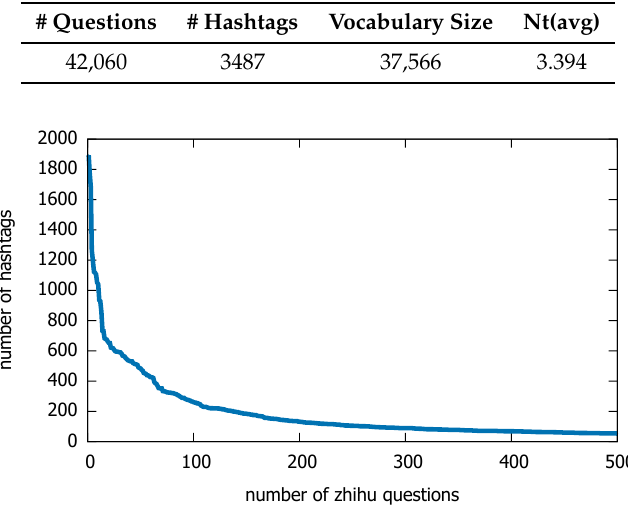
Figure 11. The distribution of the number of questions for each hashtag.